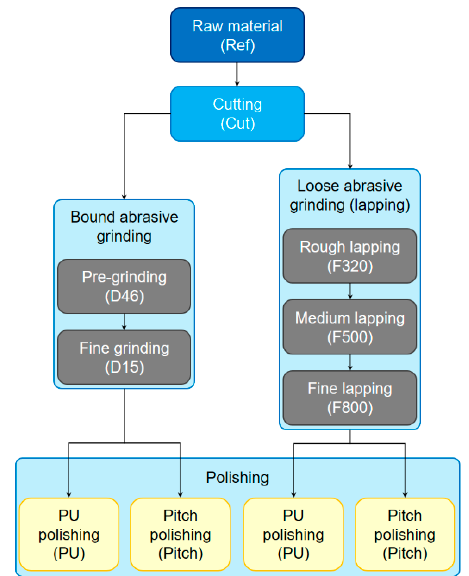
Figure 1. Workflow illustrating the preparation of the different investigated samples including the particular sample denomination used in this work (given in parentheses).